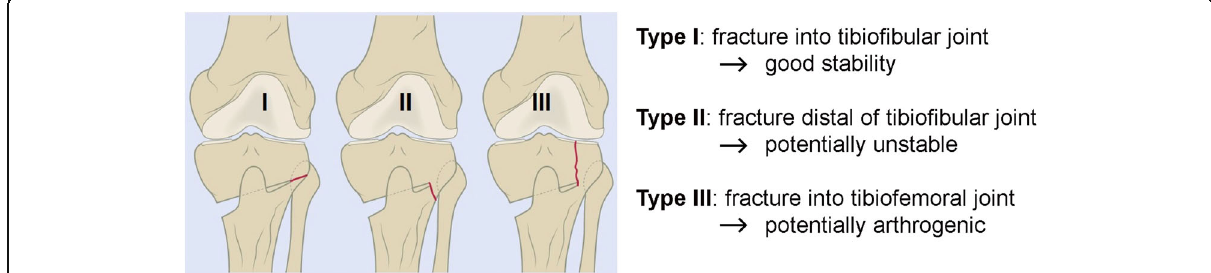
Fig. 2 The TAKEUCHI classification of fractures around cortical hinge and corresponding stability of the subtypes (adapted from (Takeuchi et al.